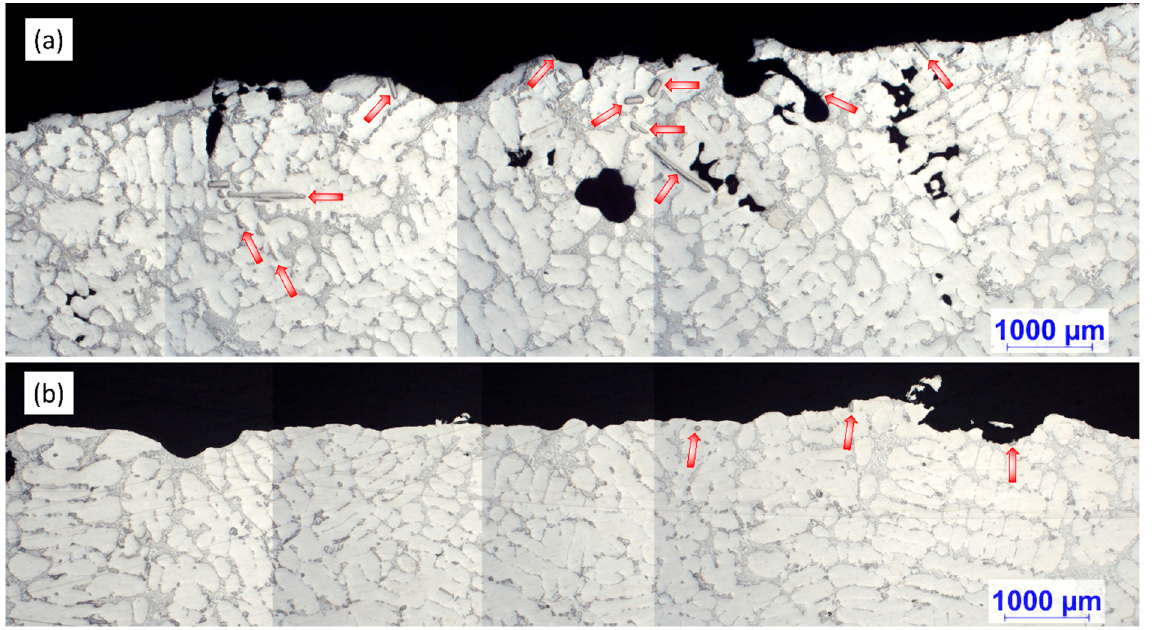
Figure 10. Optical micrograph of the top region of the ( a ) A1 and ( b ) A2 samples, indicating the places where TiAlSi particles were found.